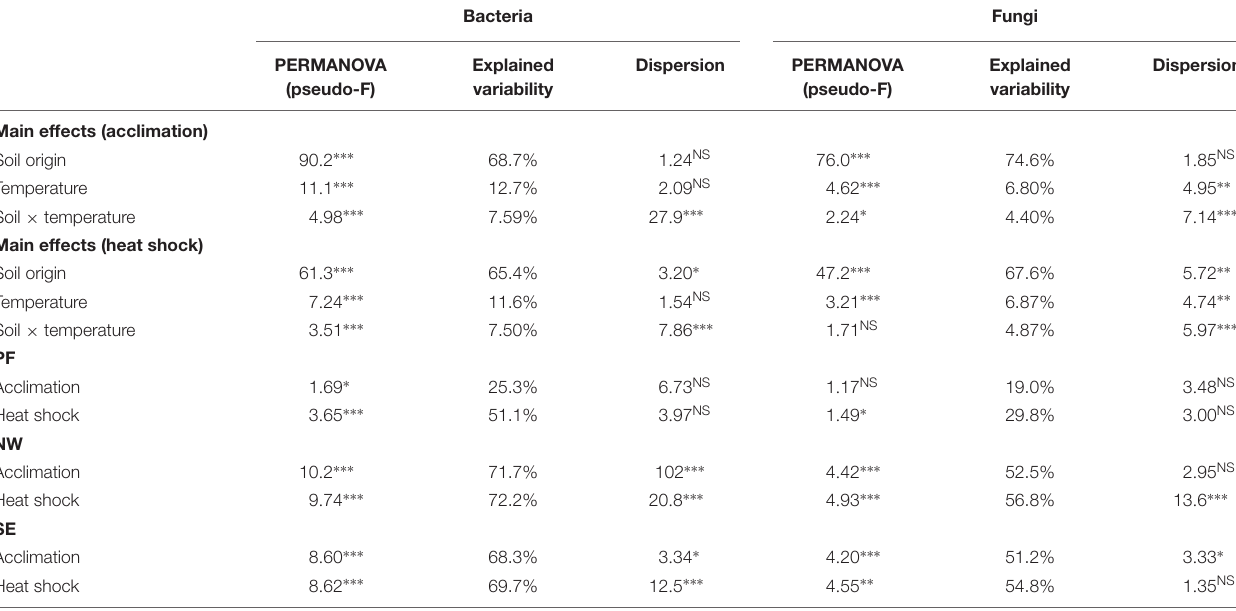
TABLE 3 | Main effects of soil origin, temperature and their interactions on bacterial and fungal beta-diversity.